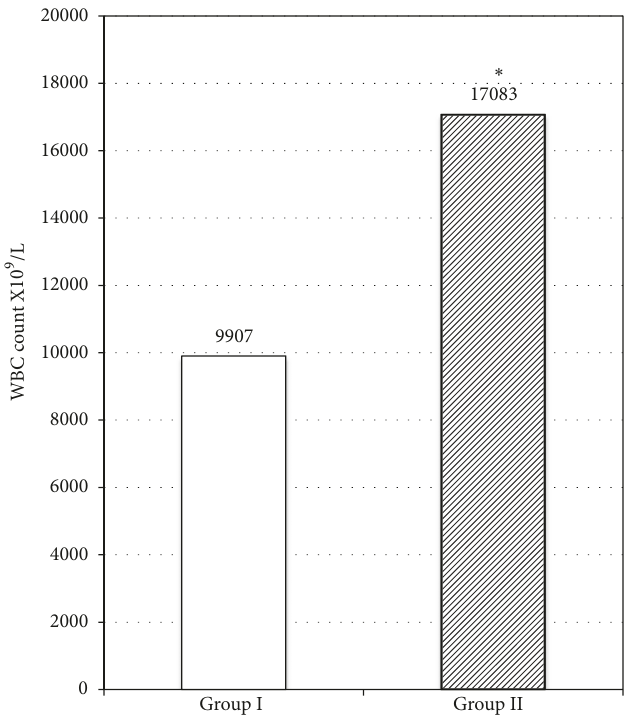
Figure 1: The average white blood cell count (WBC) of the patients with diagnosis of acute cholecystitis. ( ∗ ) The average white blood cell count (WBC) of the patients who were diagnosed to have acute cholecystitis was significantly higher in the elderly patient group (p <